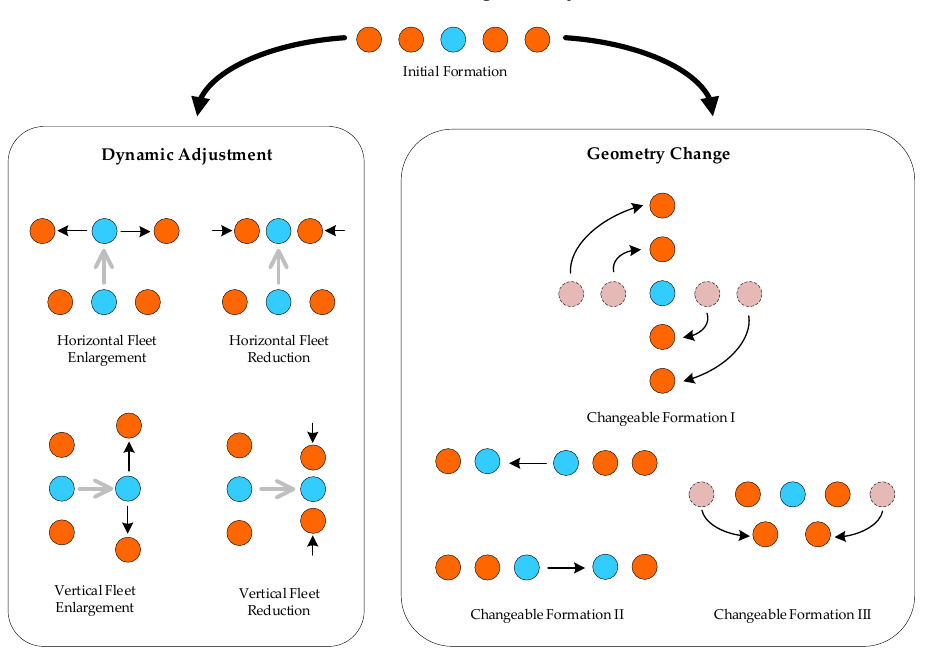
Figure 4. The formation change library of the UGVs fleet. The blue dots in Figure 4 indicate the leaders of the fleet and the remaining red dots